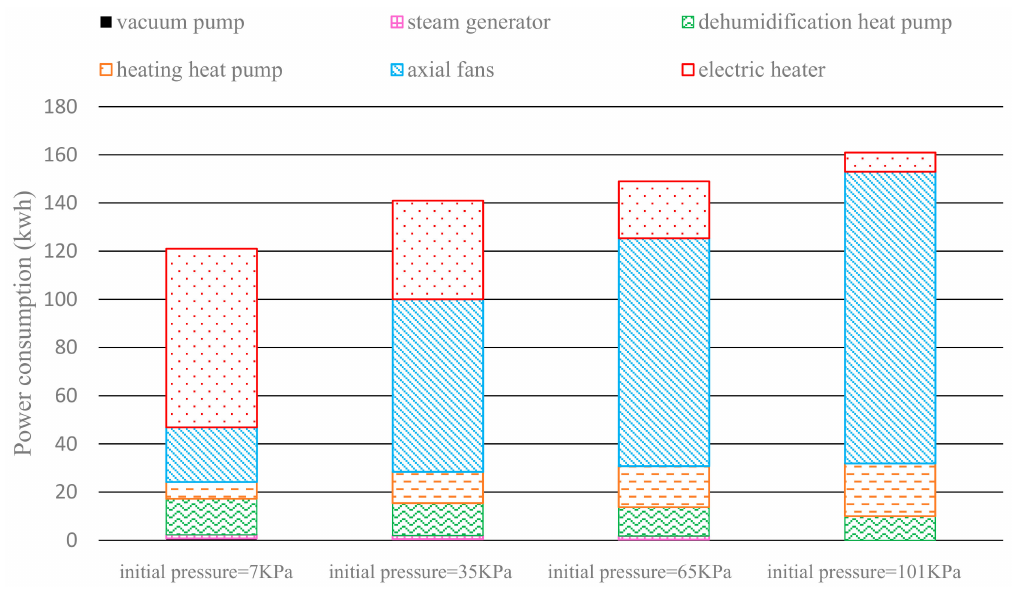
Figure 9. Power consumptions of electrical equipment under different initial